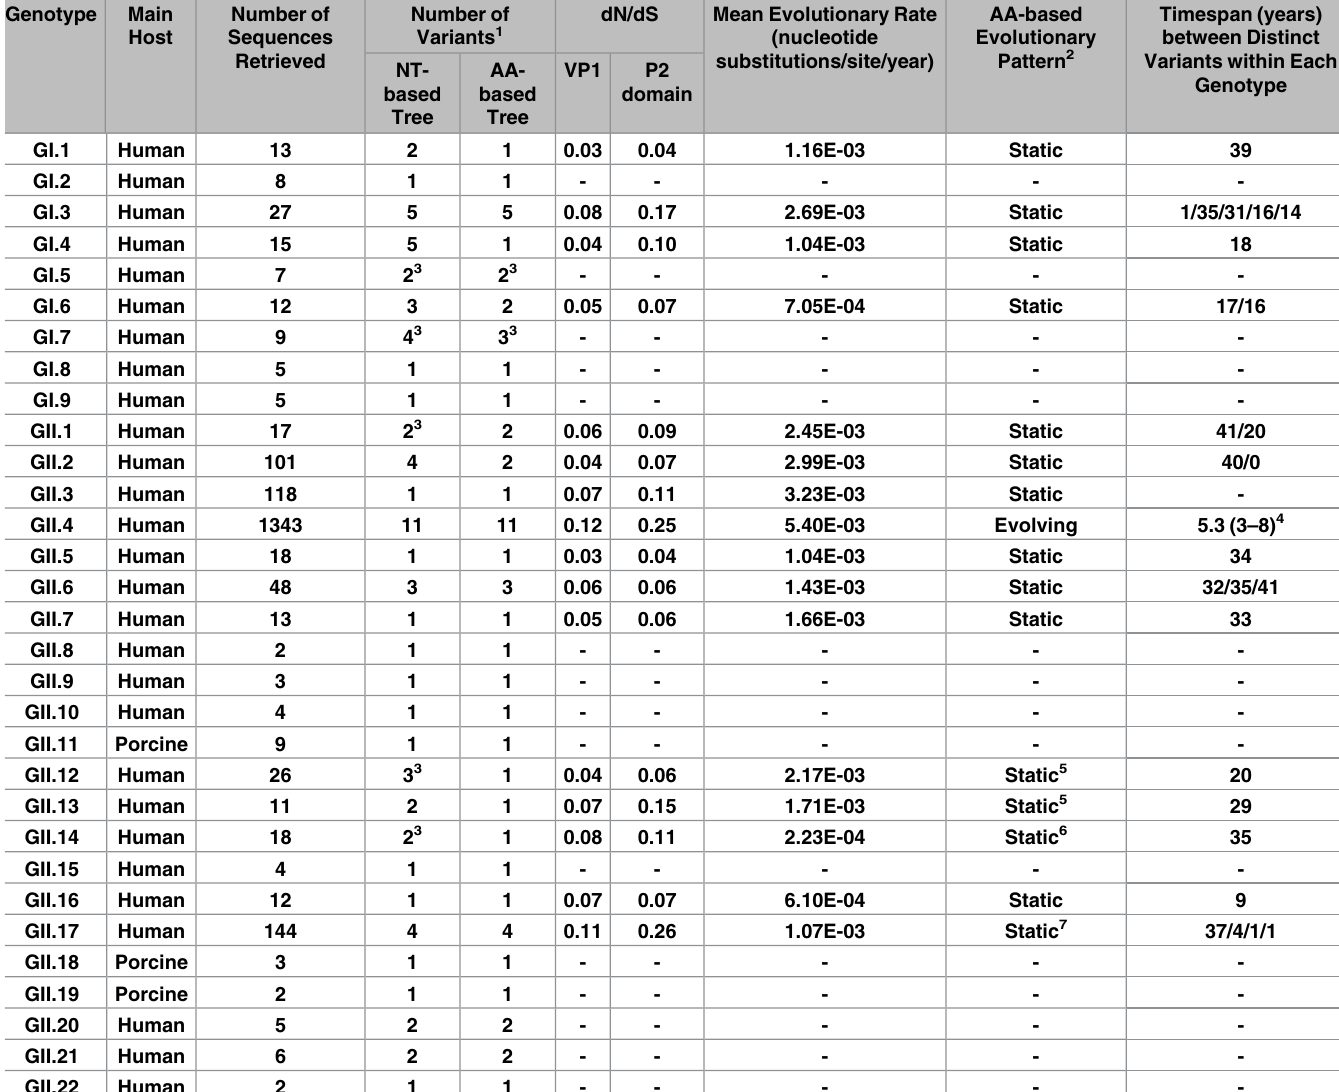
Table 1. Summaryof the sequence analysesconducted for each norovirus genotype.